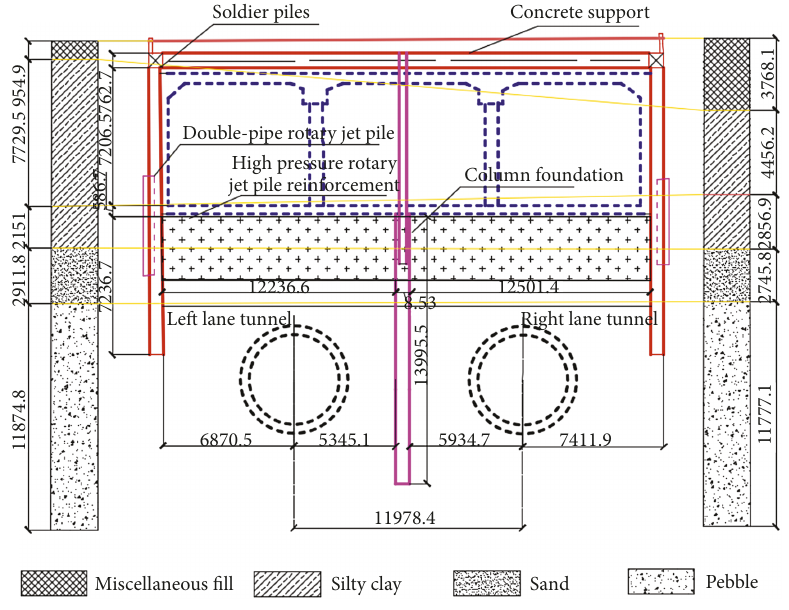
Figure 4: Geological section of envelop enclosure. Table 1: The possible risks and their levels in the